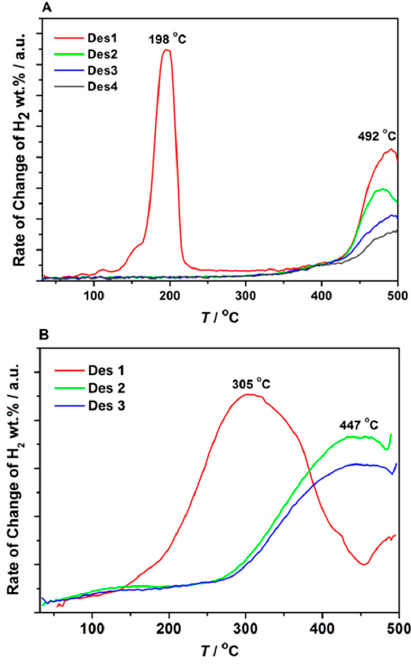
Figure 4. Differentiated Sieverts’ data for four and three desorption cycles of ( A ) bulk 2LiBH 4 -NaAlH 4 and ( B ) nanoconfined 2LiBH 4 -NaAlH 4 in CA.